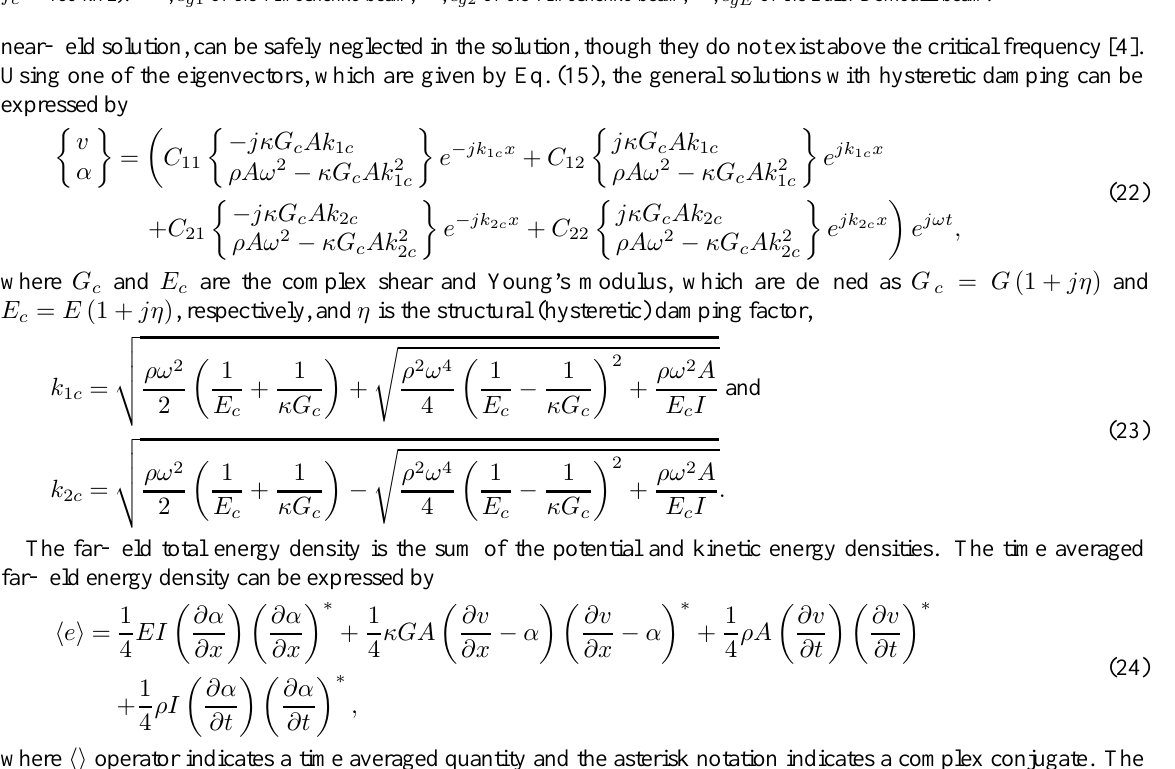
c gE of the Euler-Bernoulli